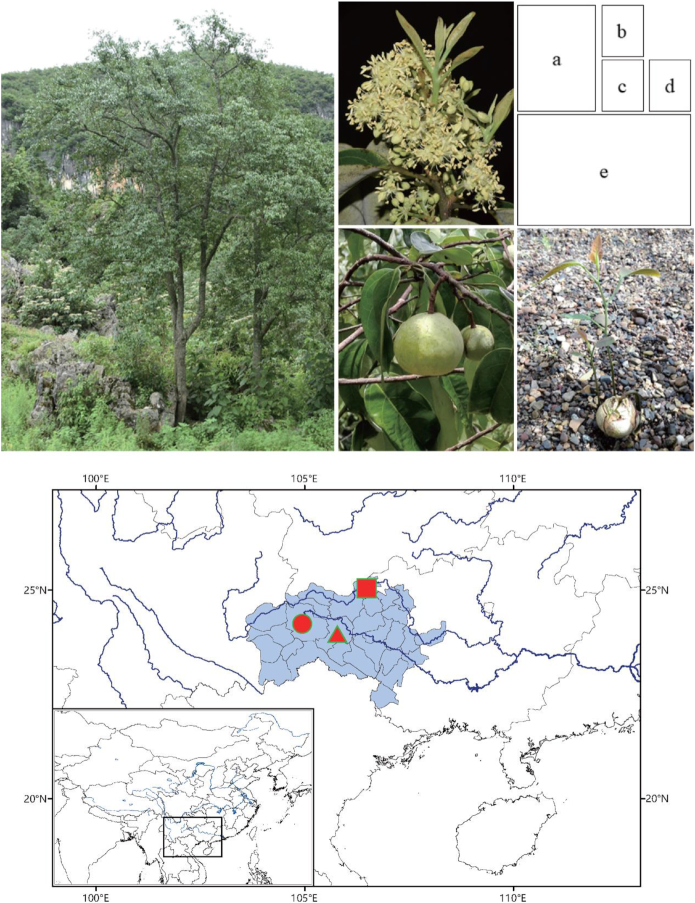
Images of M. oleifera, recorded distribution range, and sampling sites. Mature tree (a), flower (b), fruit (c), and naturally germinated seedling (d). (e) Blue-shaded region denotes the reported distribution range of M. oleifera, while the red circle denotes the position (N23.90°, E104.09°, Guangnan County, Yunnan) where one tree was sampled for whole genome sequencing, and the red triangle and square denote the positions (N23.9°, E106.00°, Funing County, Yunnan, and N24.78°, E106.57°, Leye County, Guangxi) where trees were sampled for RNA sequencing.